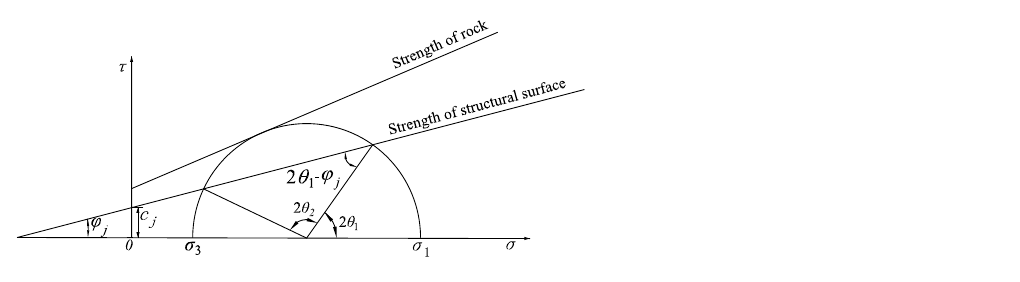
Figure 2. Range of discontinuity